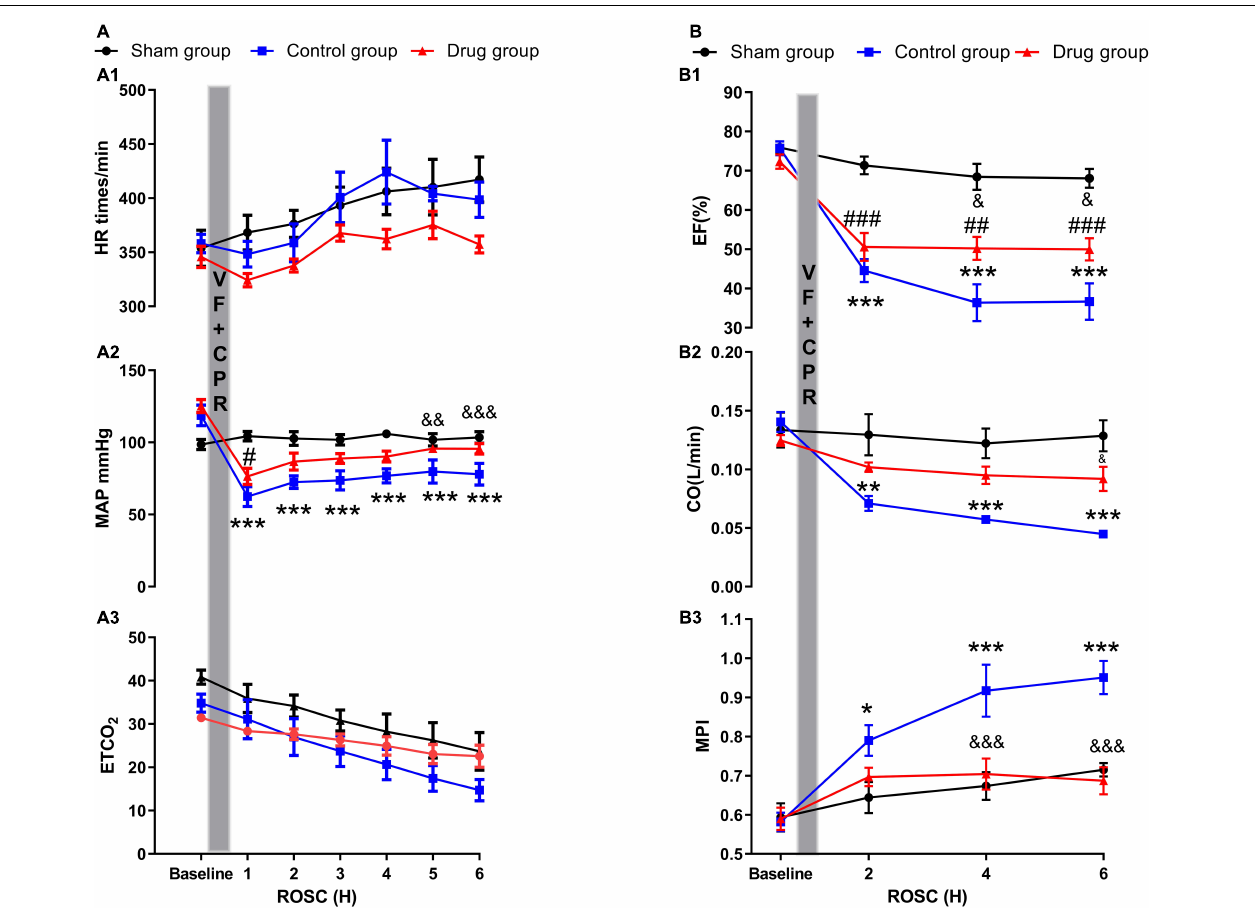
FIGURE 1 | Myocardial performance and myocardial function. (A1) Heart rate; (A2) mean arterial pressure; (A3) end-tidal CO 2 ; (B1) ejection fraction; (B2) cardiac output; (B3) myocardial performance index. HR, heart rate; MAP, mean arterial pressure; ETCO 2 , end-tidal CO 2 ; CO, cardiac output; EF, ejection fraction; MPI, myocardial performance index; VF, ventricular fibrillation; CPR, cardiopulmonary resuscitation; ROSC, return of spontaneous circulation. Values are presented as mean ± SD ( n = 6 in each group). * p < 0.05, ** p < 0.01, *** p < 0.001 control vs. sham group; & p < 0.05, && p < 0.01, &&& p < 0.001 drug vs. control group;